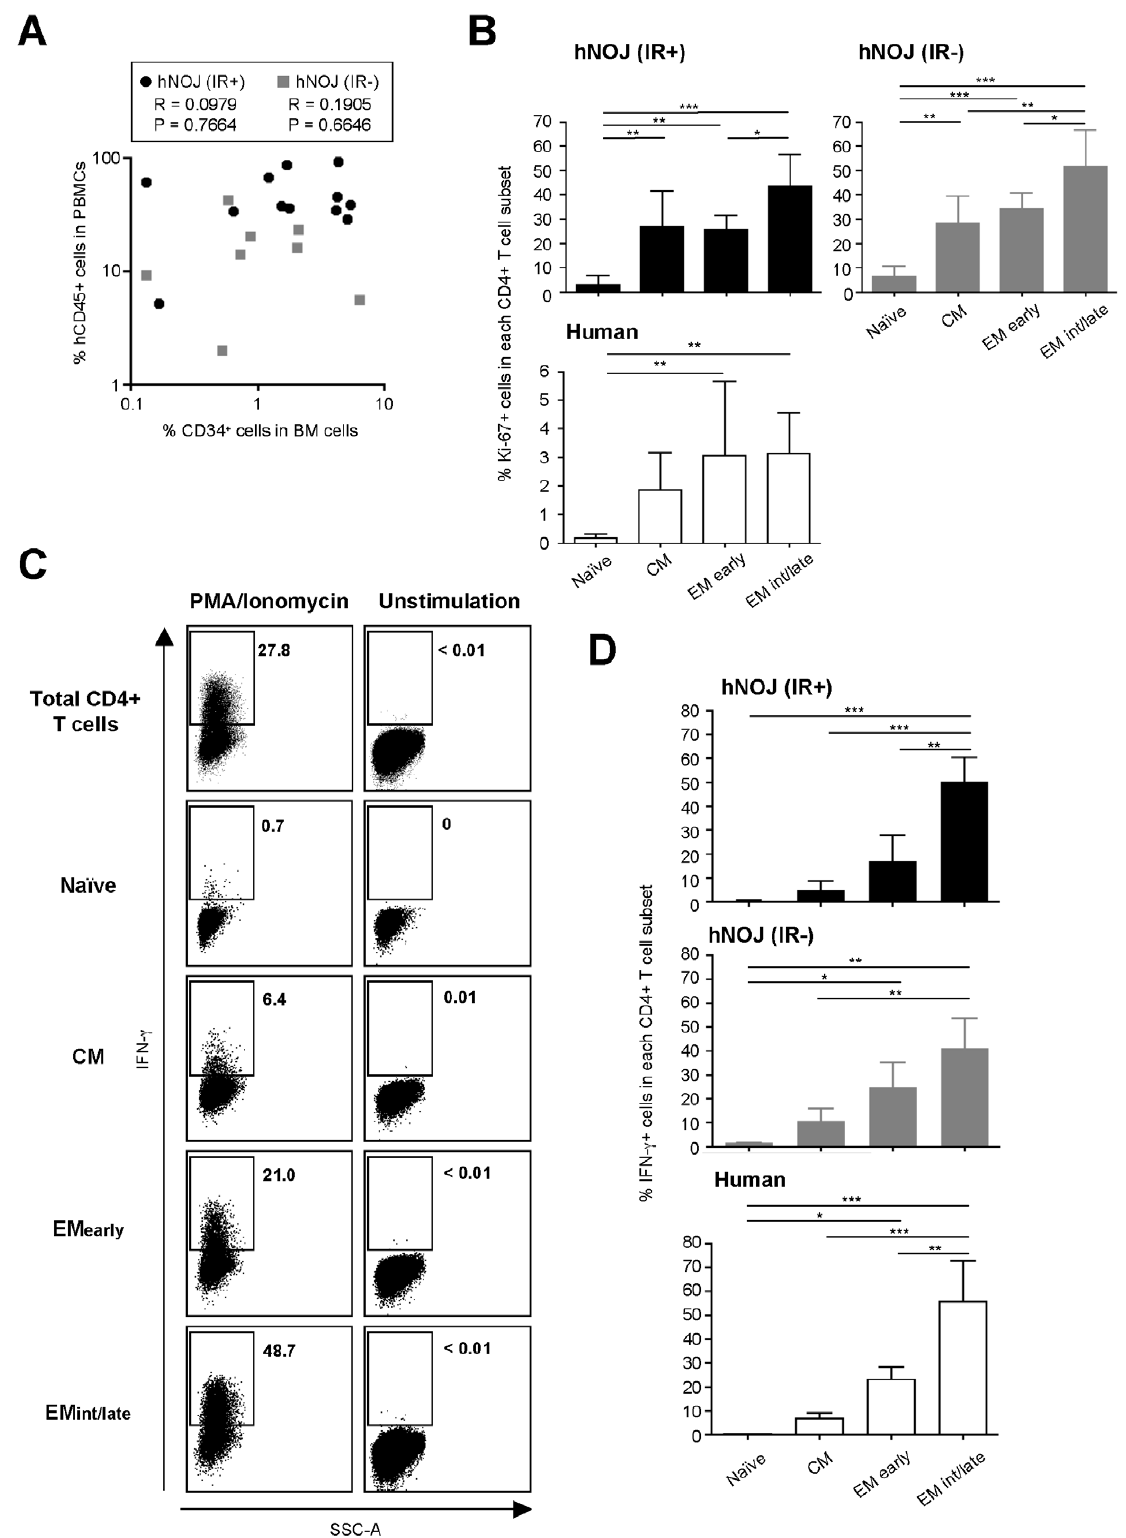
Figure 5. Possible occurrence of HSP of CD4 + T Cells in hNOJ mice. (A) Association between the percentage of hCD45 + cells within the PBMC population and that of CD34 + cells in the BM cells from hNOJ (IR + ) and hNOJ (IR 2 ) mice at $ 16 wk post-transplantation ( n =12 and n =8, respectively). Spearman’s rank correlation coefficient was used for statistical analysis. (B) Percentage of Ki-67 + cells among naı¨ve, CM, EM early , and EM int/late subsets of splenic CD4 + T cells from hNOJ (IR + ) and hNOJ (IR 2 ) mice at $ 16 wk post-transplantation ( n =6 and n =6, respectively) and from human PBMCs ( n =10). Data are expressed as the mean 6 SD. Significant differences ( * P , 0.05, ** P , 0.01, *** P , 0.001) were determined by Tukey’s